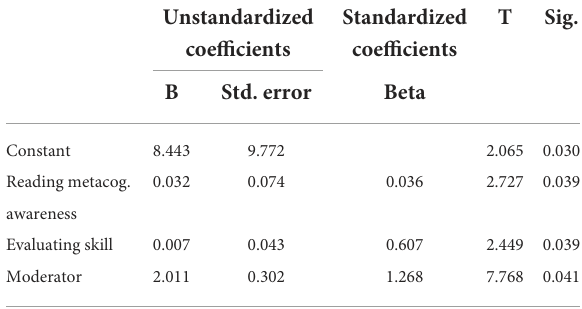
TABLE 11 Effect of reading metacognitive awareness on evaluating skill.